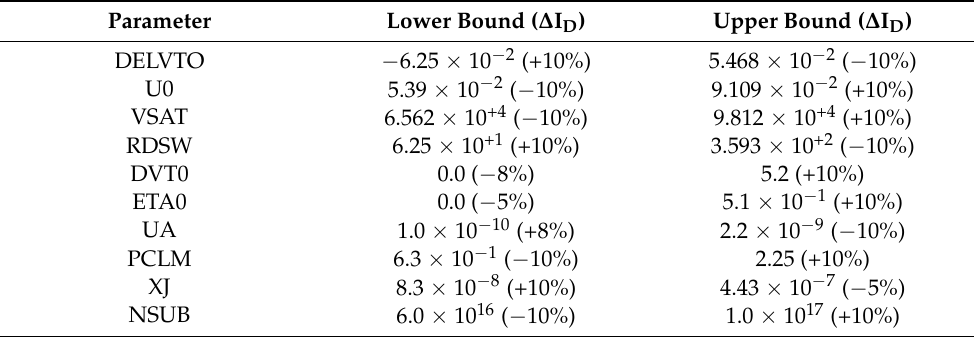
Table 1. The list of parameters and specification for the experiment. Lower and upper bound is set up to keep the physical meaning up in the optimization process. The number format for the boundary is the engineering format. The type and the physical parameters for the experiment is N channel MOSFET and length/width = 0.1 µ m/1 µ m, respectively. The value in the parentheses follows by bound value of parameter is the relative variation of the on current by parameter change at the bound compared to the reference, BSIM4 (cid:48) s default